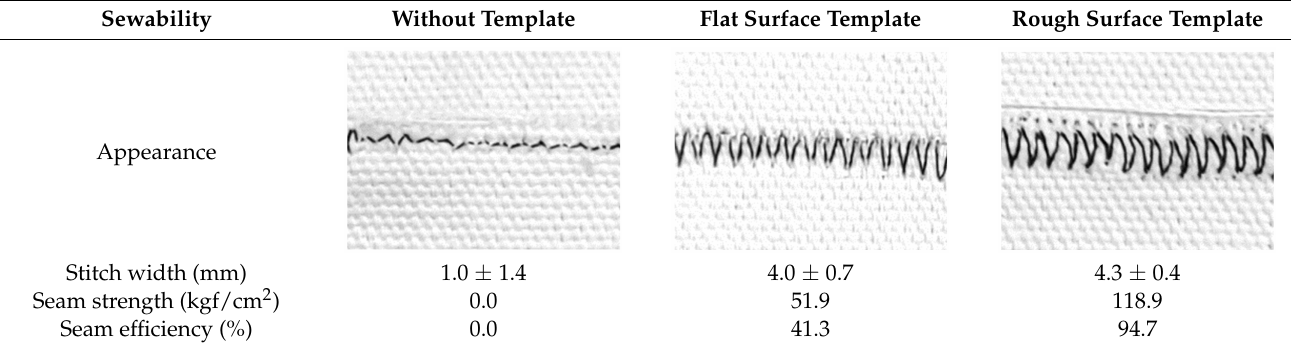
Table 2. Appearance and sewabilities of the sewn part according to the template